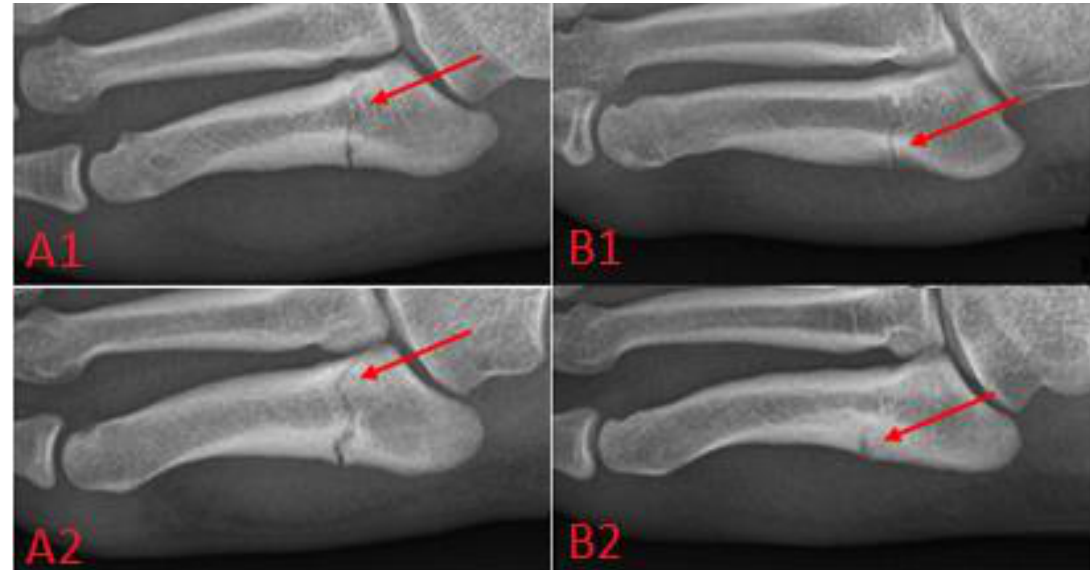
Figure 3. New classification of the proximal 5th metatarsal fractures, according to K. T. Lee: ( A1 ) acute complete fracture, ( A2 ) chronic complete fracture, ( B1 ) incomplete fracture below 1 mm, ( B2 ) incomplete fracture of 1 mm or more.